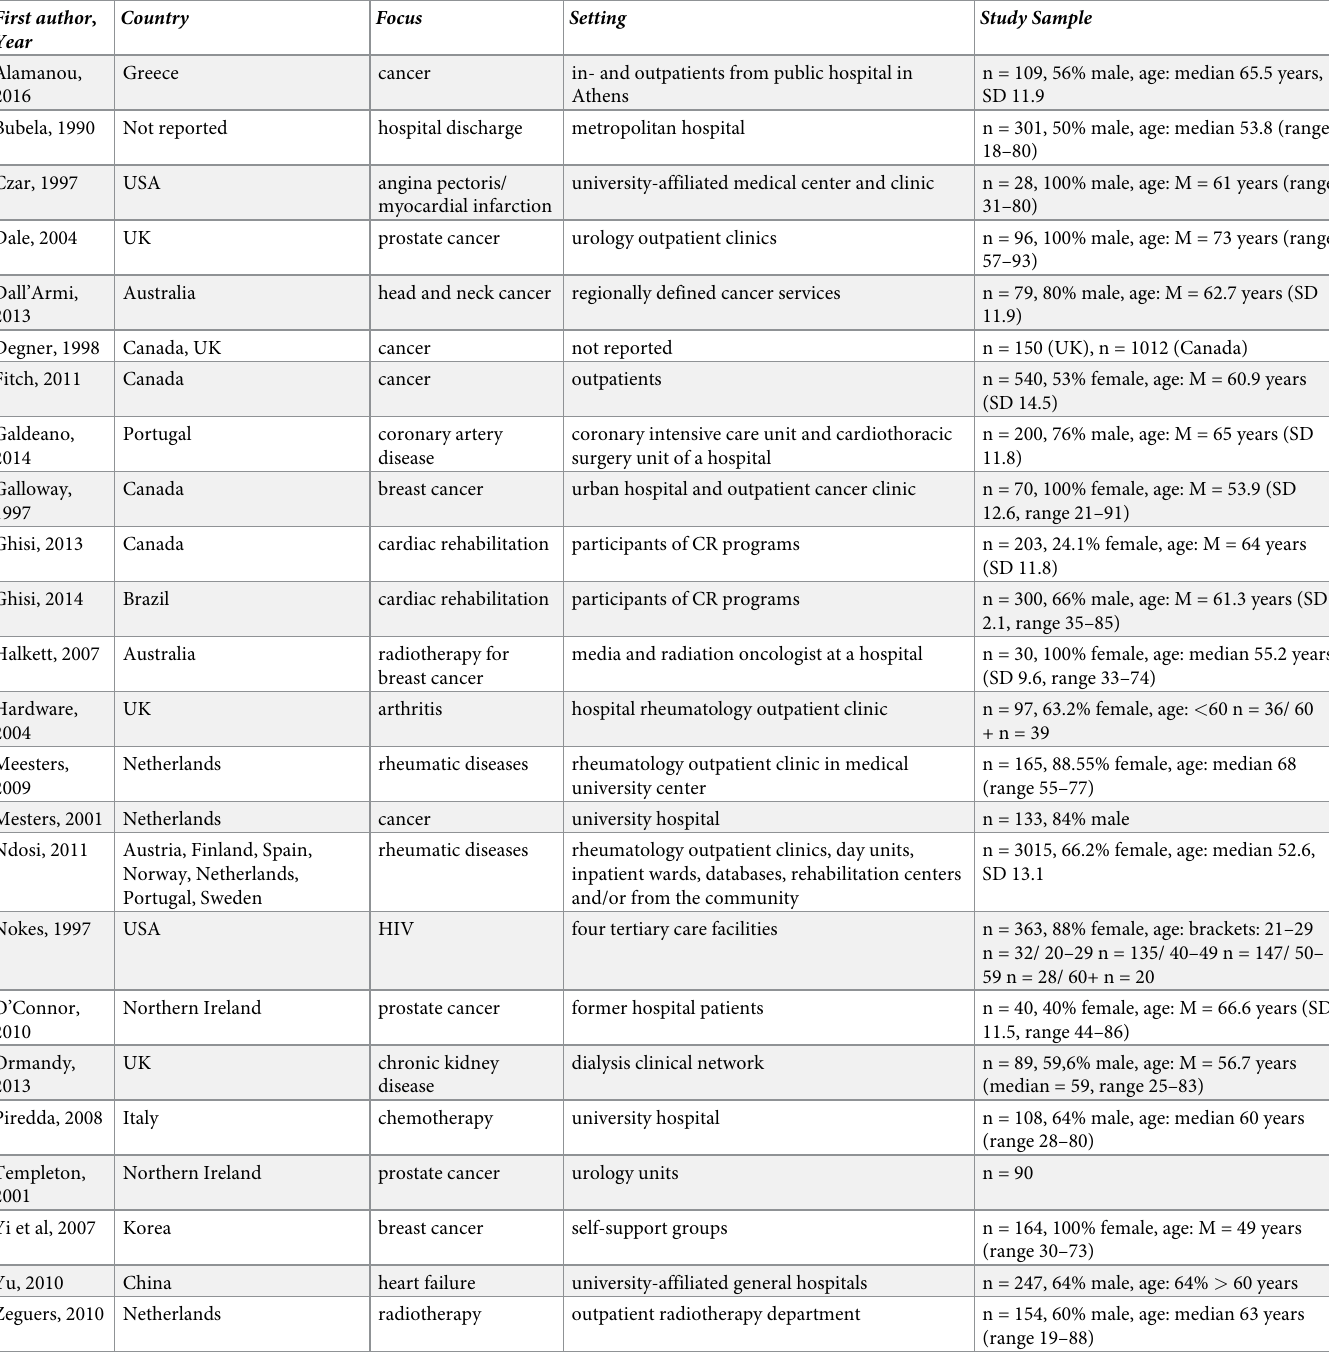
Table 3. Descriptive data of the included